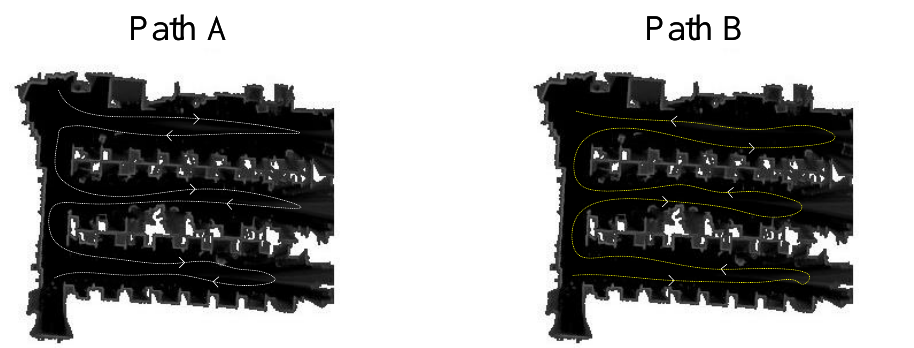
Figure 8. Experimental environment.